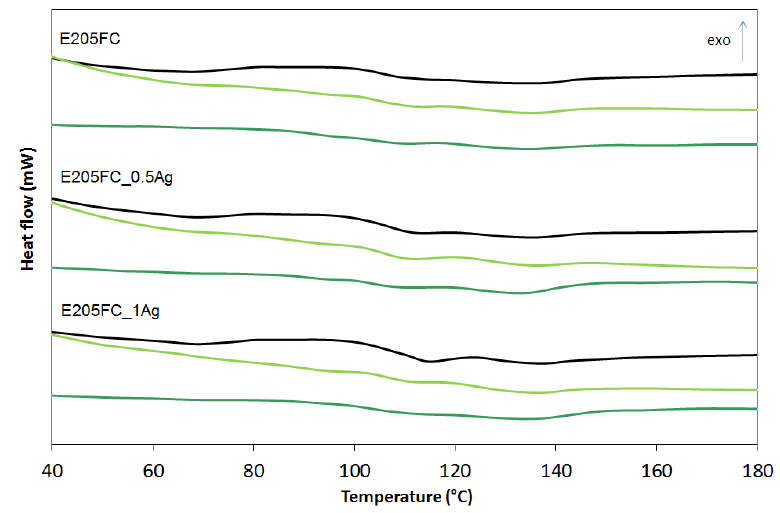
Figure 8. Glass transition temperature ( T g ) of pure polymer (E205FC) and polymer containing 0.5 wt % and 1.0 wt % of silver nanoparticles AgNPs before incubation (black line), after 12 months (light green line) and after 24 months of incubation (dark green line).